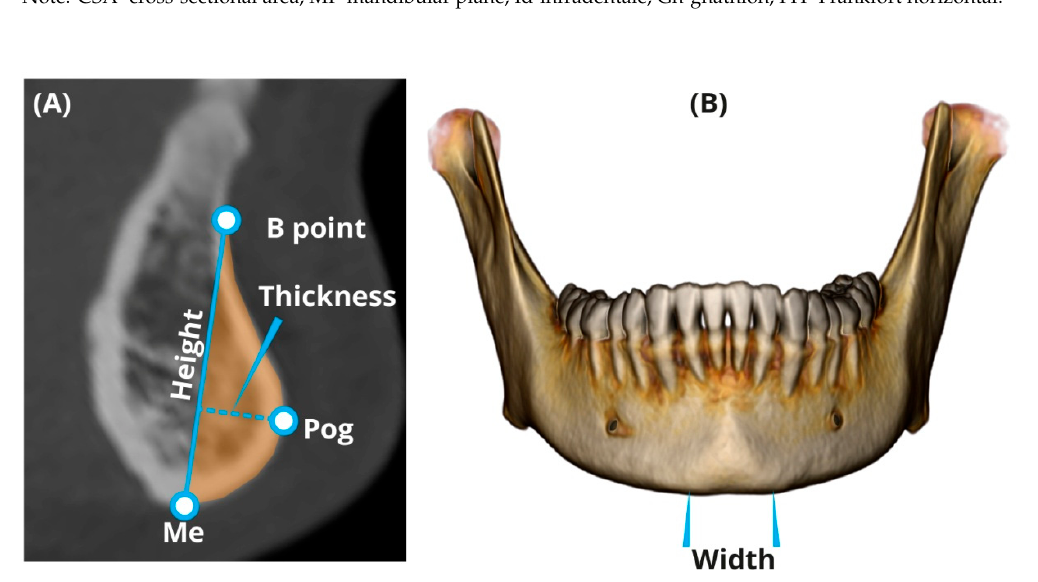
Figure 3. Measurements of symphysis. ( A ) Height, thickness, and CSA (in light pink). ( B ) Symphysis orientation ( β angle) and inclination ( α angle). Me—menton, Pog—pogonion, Po—porion, Or—orbitale, Go—gonion, Id—infradentale, Gn—gnathion, plane,